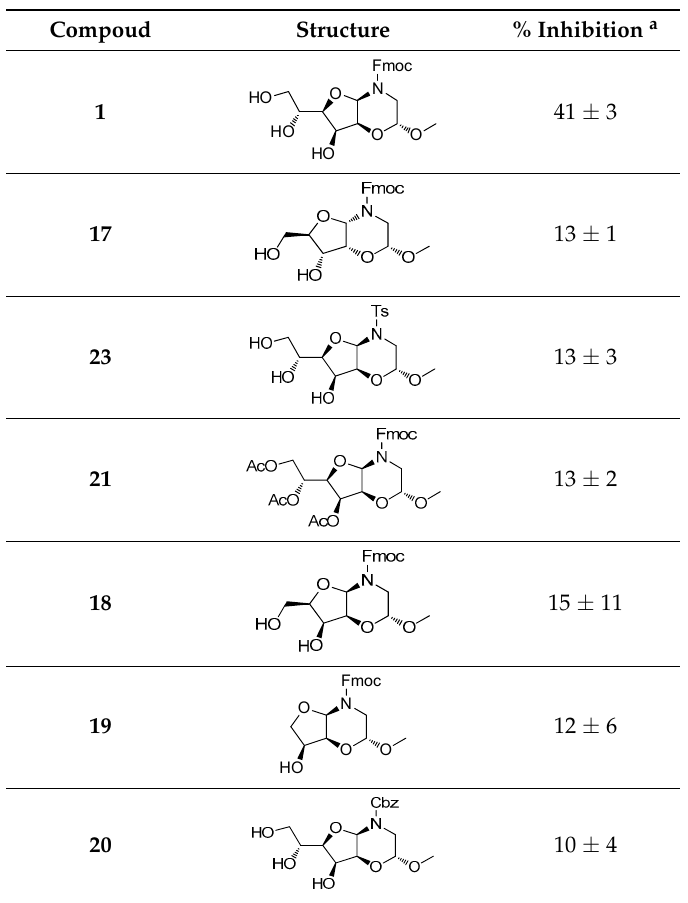
a Cell growth inhibition (% vs control) in MDA-MB-231 cells after 48 h of incubation with compound 1 at the reported concentration. Values ± SD indicate the mean of three independent experiments.